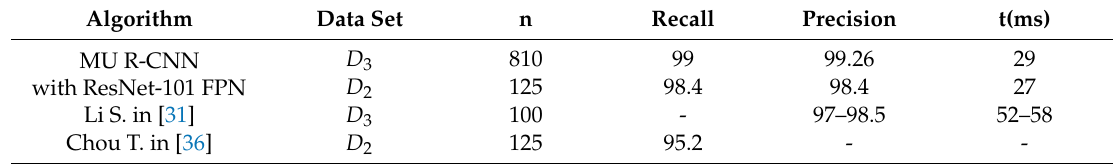
Table 8. The performances of proposed algorithm compared with relevant